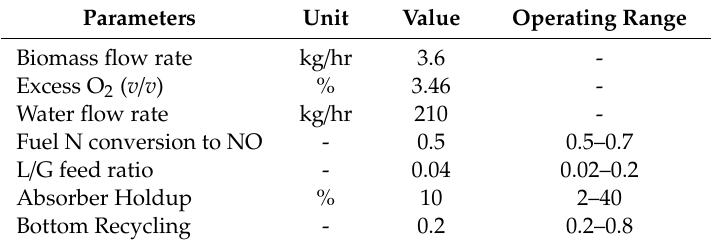
Table 2. Parameters and operating conditions used in the steady state